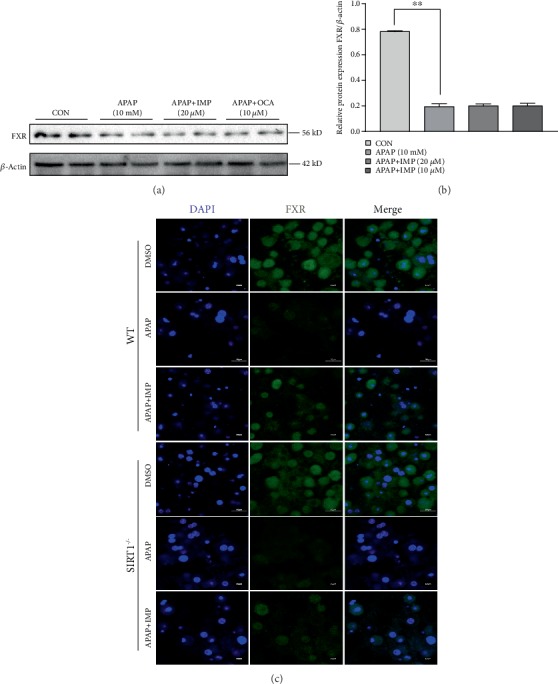
Activation of FXR mediated by IMP or OCA treatment is partially lost in SIRT1−/− PMHs. (a) The protein expression of FXR in SIRT1−/− PMHs was analyzed by Western blot. (b). Quantitative analysis of scanning densitometry of protein bands for FXR in SIRT1−/− PMHs. (c) FXR localization was performed using immunofluorescence staining and observed using a confocal laser scanning microscope (magnification: 400x) stained by an anti-FXR antibody (1 : 100) with Alexa Fluor 488-conjugated detection antibody. The nucleus is stained with DAPI. Results are expressed as compared to the DMSO-treated control group. ∗p < 0.05; ∗∗p < 0.01; ∗∗∗p < 0.001. IMP: imperatorin; APAP: acetaminophen; OCA: obeticholic acid; SIRT1: Sirtuin 1; FXR: Farnesoid X receptor; DAPI: 2-(4-amidinophenyl)-6-indolecarbamidine dihydrochloride; SEM: standard error of mean.